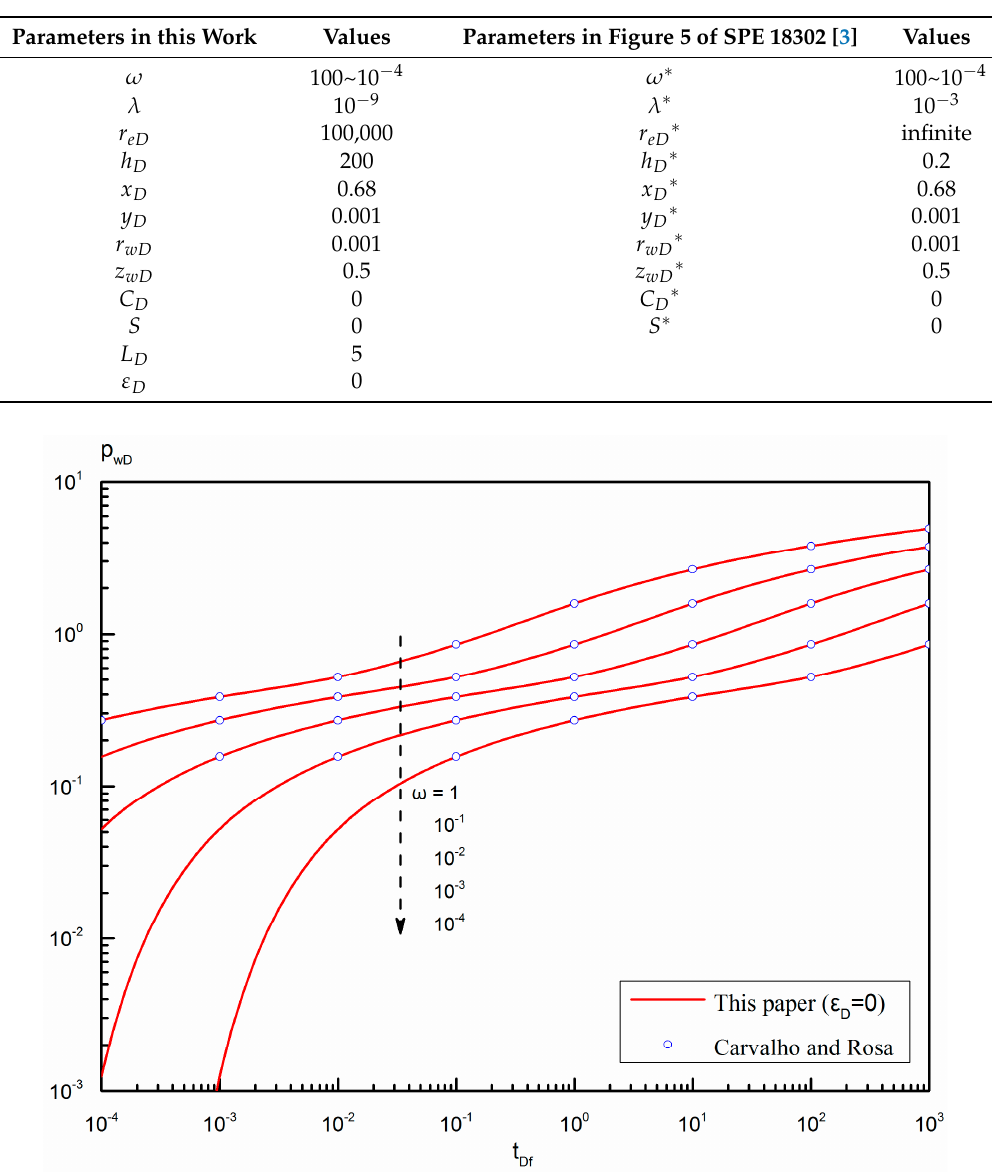
Figure 3. Verification of a horizontal well in a naturally fractured reservoir without stress sensitivity ε = ). ( ε D = ( 0 D